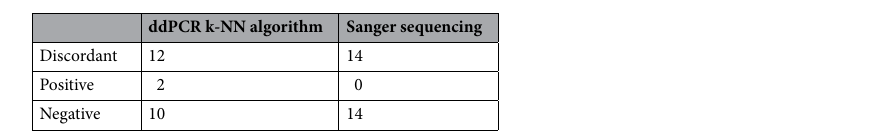
Table 1. Discordant BRAF V600E status relative to the pyrosequencing